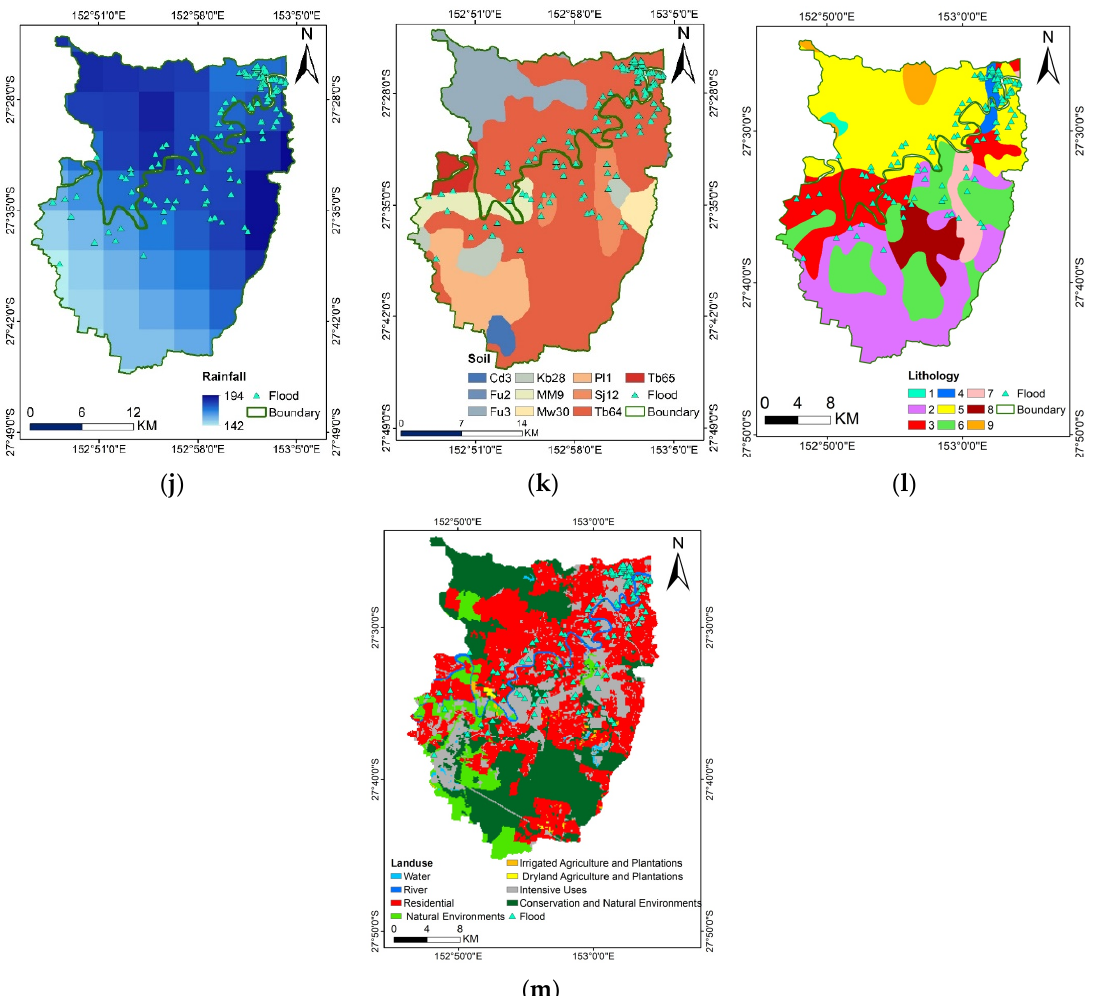
Figure 2. Thirteen explanatory factors for model development in this study: ( a ) altitude, ( b ) slope, ( c ) aspect, ( d ) curvature, ( e ) distance to river, ( f ) distance to road, ( g ) SPI, ( h ) TWI, ( i ) STI, ( j ) total annual rainfall, ( k ) soil, ( l ) lithology, and ( m ) land use. Table 1. Lithology contents and classes in the study area.